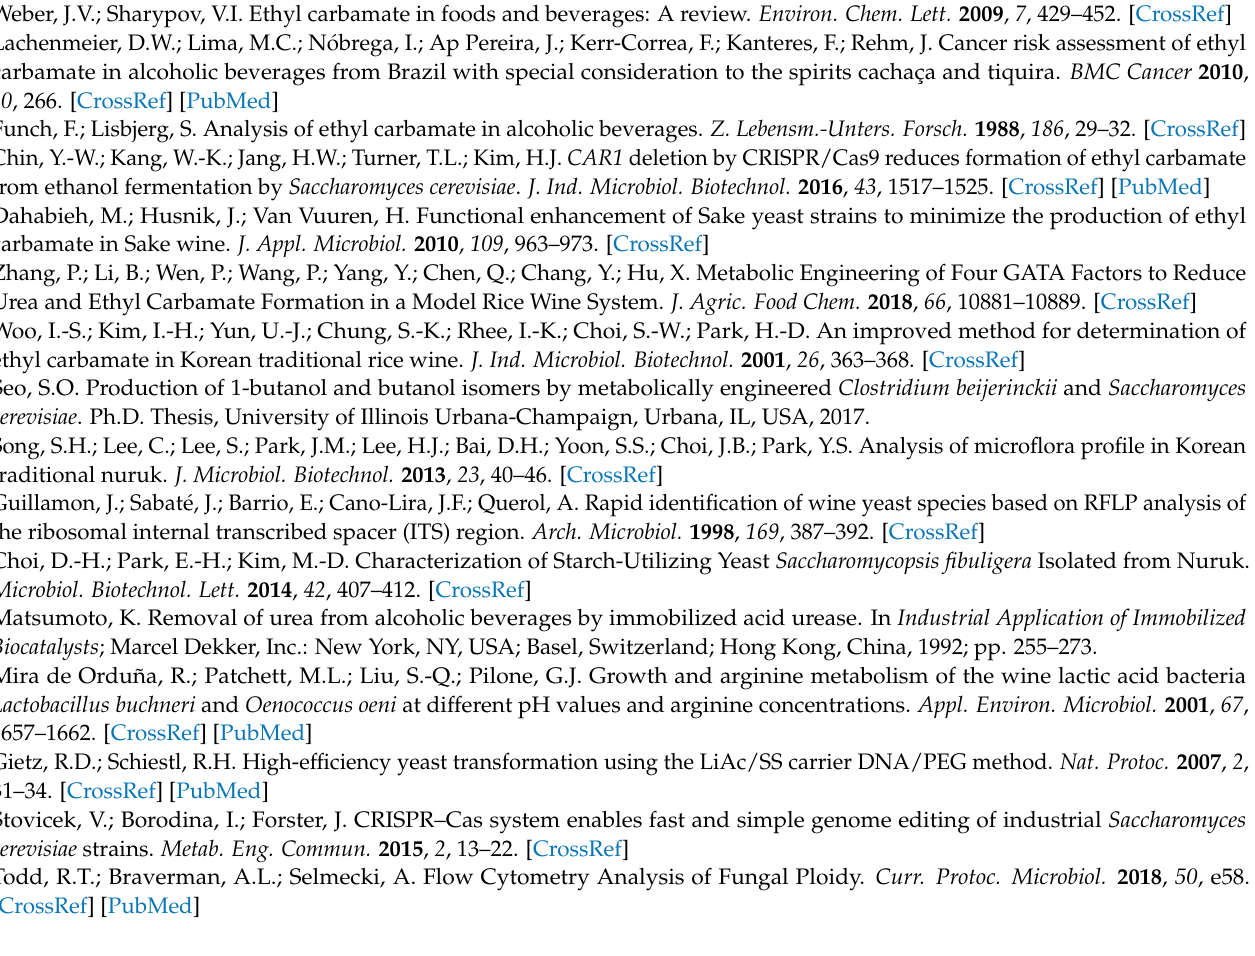
as a starter culture; Table S1: Comparison of the fermentation capability in batch fermentation at 12 h; Table S2: Comparison of the ethyl carbamate concentration in batch fermentation; Table S3: Compari- son of the ethyl carbamate concentration in Makgeolli fermentation by the wild-type S. cerevisiae GRL6 and the engineered S. cerevisiae dCAR1 , dGZF3 , and dCAR1&GZF3